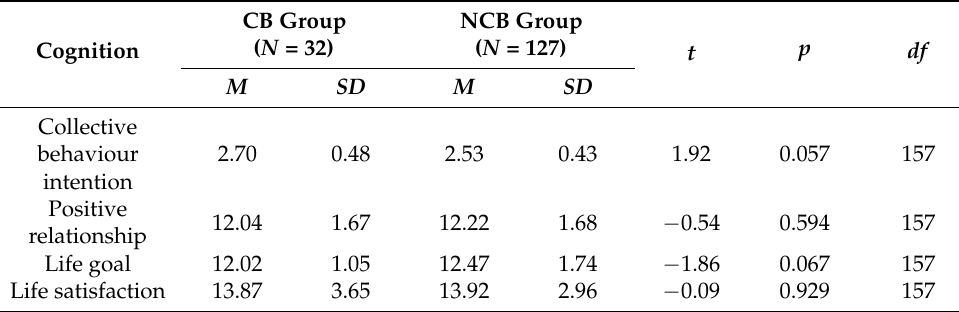
Table 4. Comparison of cognition between CB and NCB